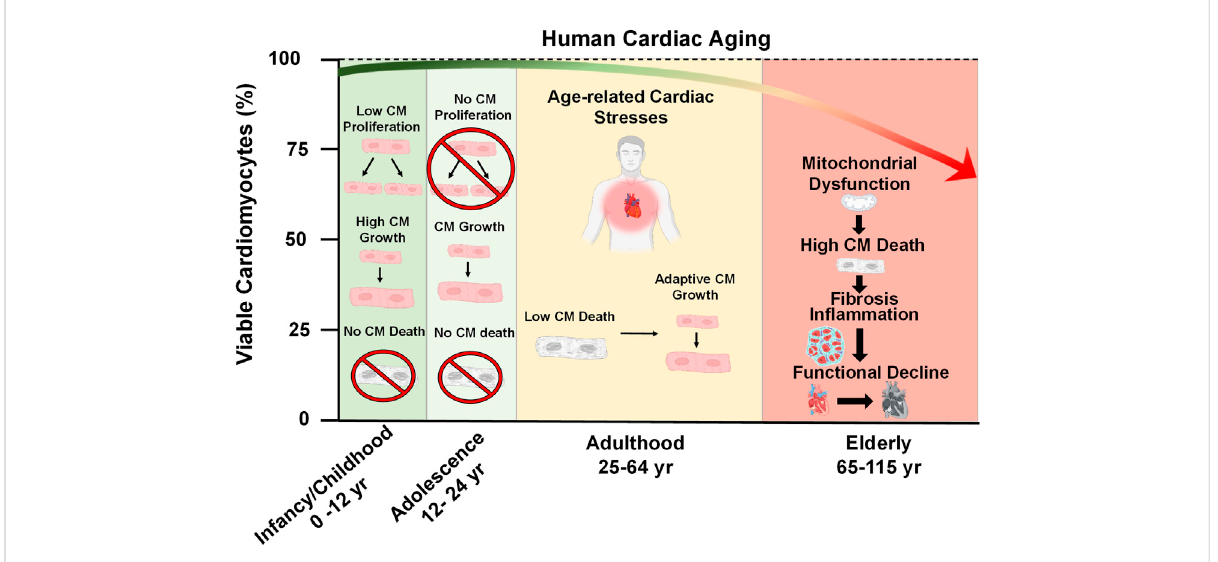
FIGURE 1 Cardiac Aging. At the time of birth, the postnatal human heart exhibits a brief period of cell growth through proliferation. However, this proliferative capacity is lost shortly after birth and heart growth proceeds by an increase in cardiomyocyte (CM) size throughout adolescence (ages 12 – 24). During adulthood (ages 25 – 64), a decline in heart function occurs due to the emergence of pathological age-related stresses, such as imbalances in force distribution per myocyte as a result of natural CM dropout, altered metabolism, decreased ATP generation, and accumulation of reactive oxygen species. These stresses consequently lead to mitochondrial dysfunction, increased CM death, in fl ammation, fi brosis, and the overall functional decline of the heart late in